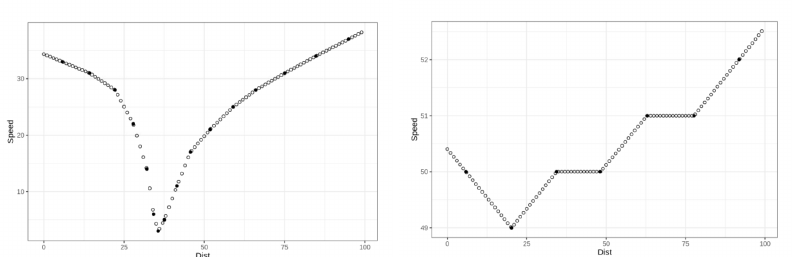
Figure 4. Speed measurements (solid dots) and interpolated values (empty dots) for one trip at an ST ( left ) or at a TL ( right ).